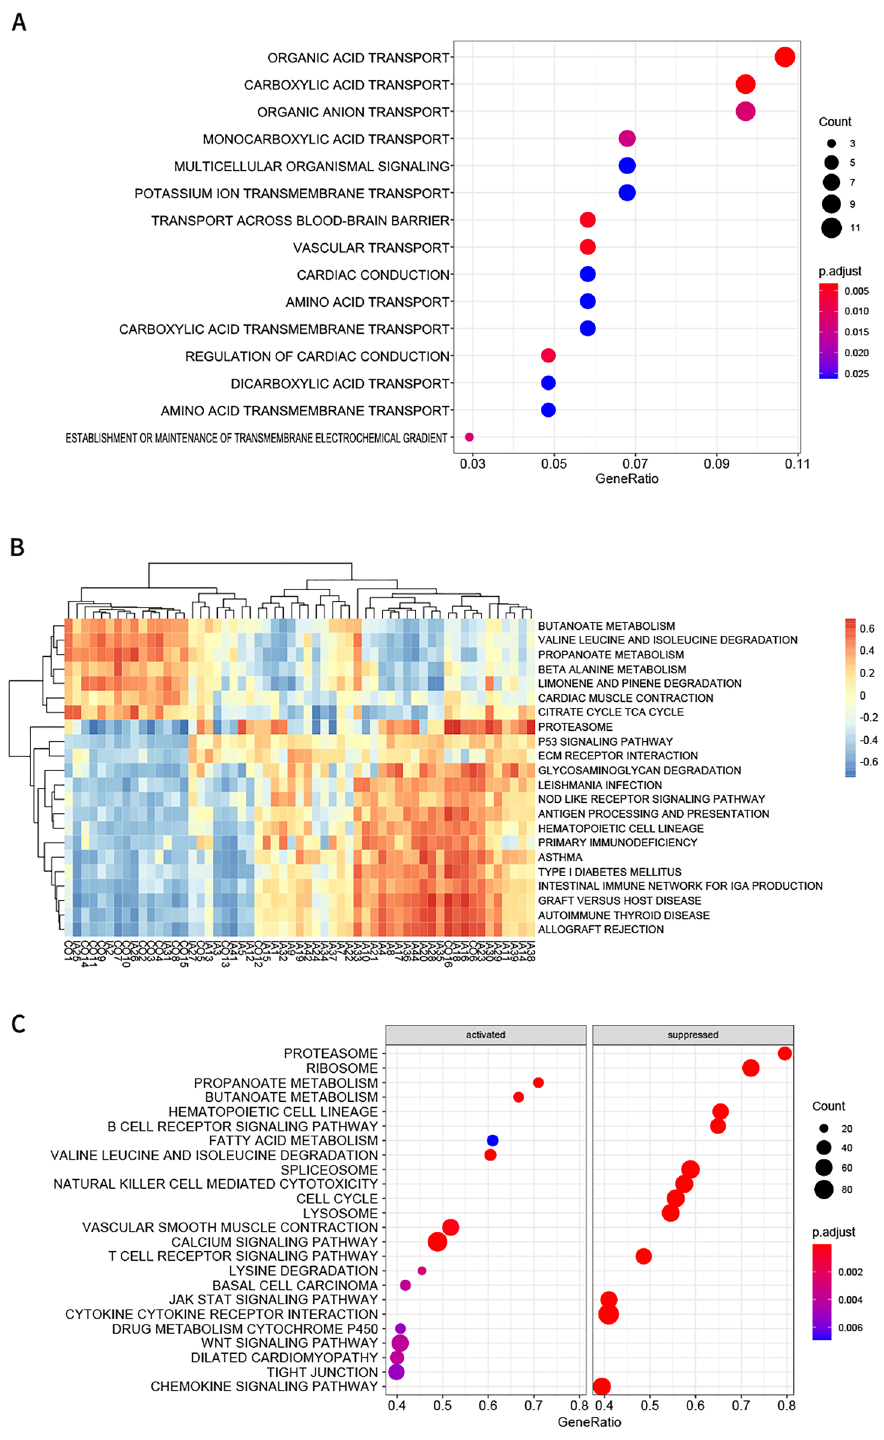
Figure 4. Functional enrichment of the green module. ( A ) Bubble plots of biological process of GO analysis. ( B ) Heatmap of differentially KEGG pathways via GSVA. ( C ) Heatmap of SLC2A12 most related pathways via single gene